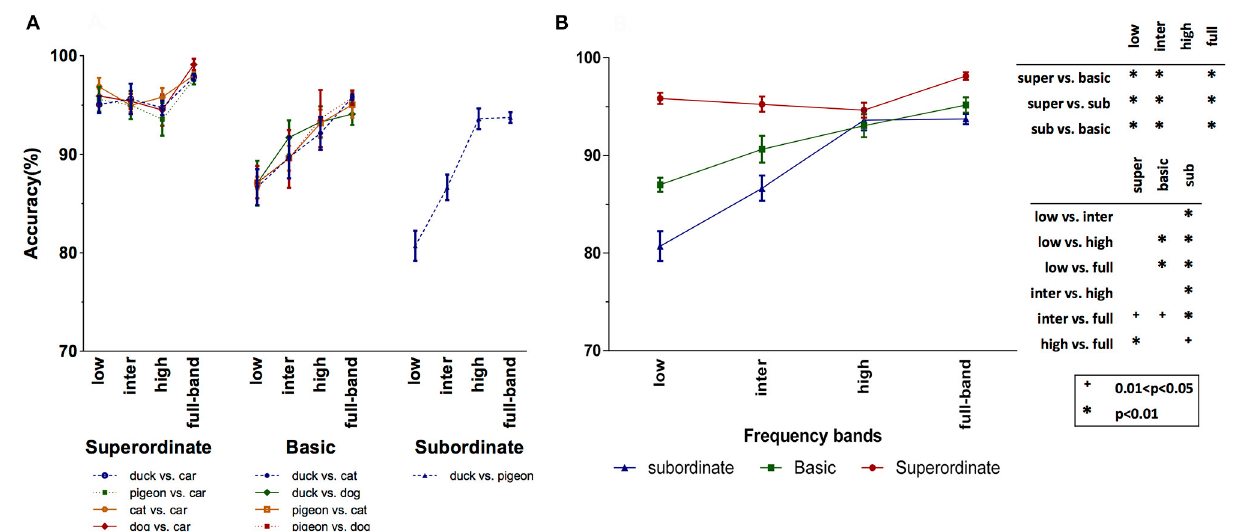
FIGURE 4 | Subjects’ mean accuracy for different categorization levels and spatial frequency bands. (A) Subjects’ accuracy for the different tasks of each categorization level. (B) Average accuracies over the different tasks of the superordinate (duck vs. car, pigeon vs. car, cat vs. car, and dog vs. car), basic (duck vs. cat, duck vs. dog, pigeon vs. cat, and pigeon vs. dog) and subordinate (duck vs. pigeon) levels. The p -value matrix presents the significant and strongly significant values using + and * signs, respectively. Error bars represent standard error of the mean (SEM). The between (within) group degree of freedom (df) is 11